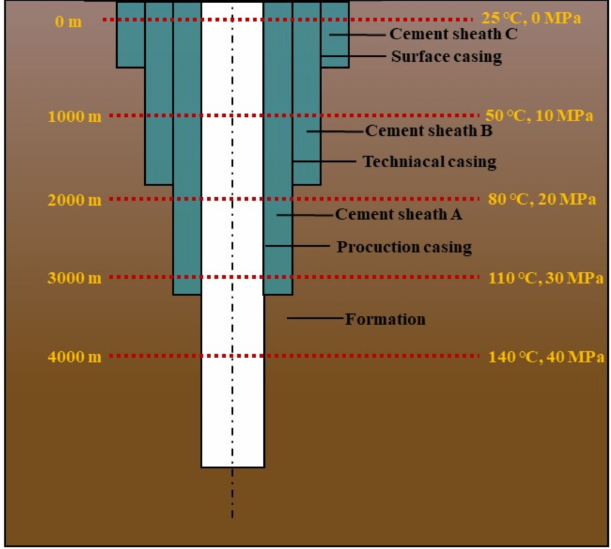
Figure 2. Wellbore structure and typical temperature-pressure environment with increase of